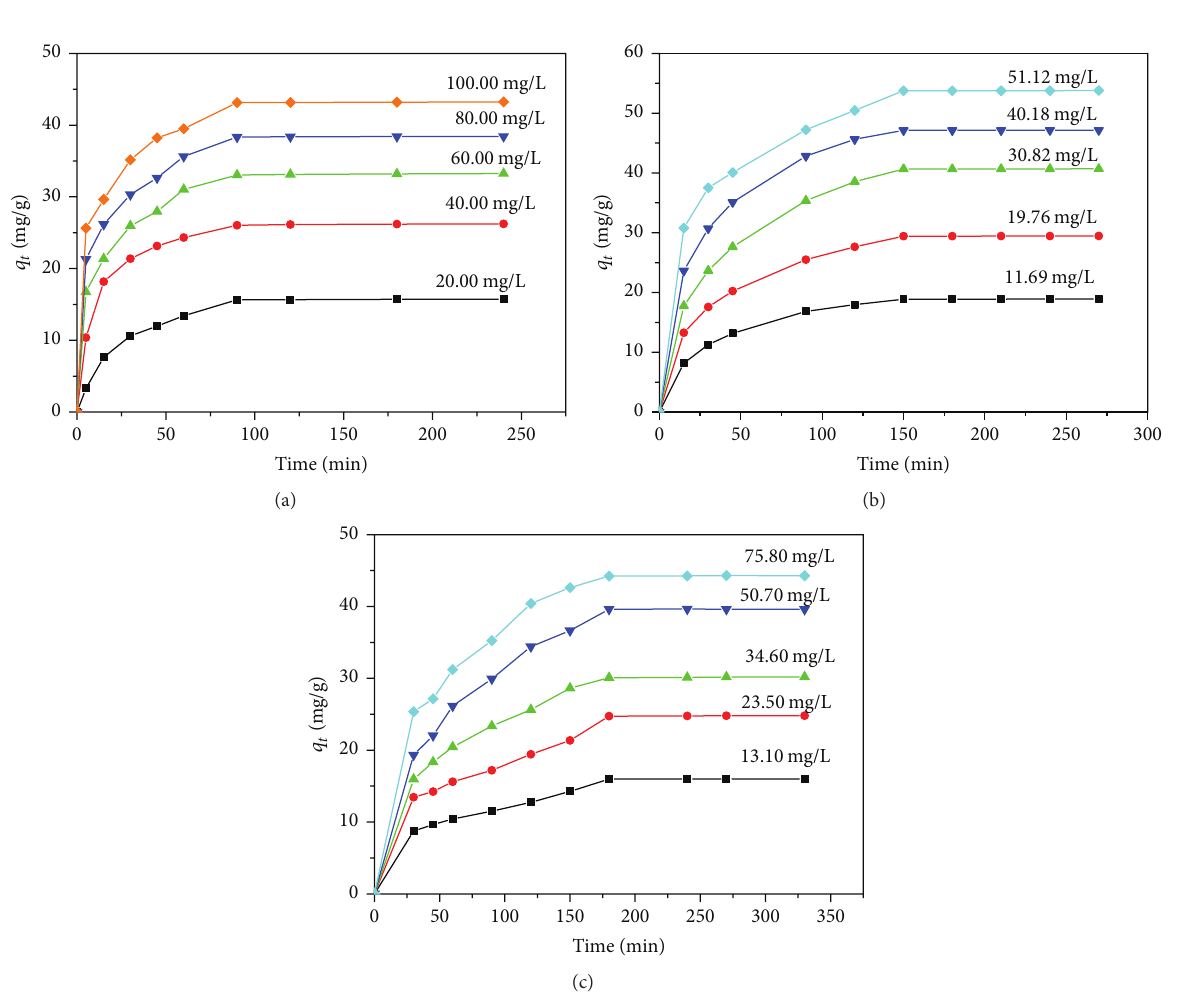
Figure 8: Adsorption kinetics of As(V) (a), Ni(II) (b), and Pb(II) (c) over Fe 3 O 4 /rGO with different concentrations.